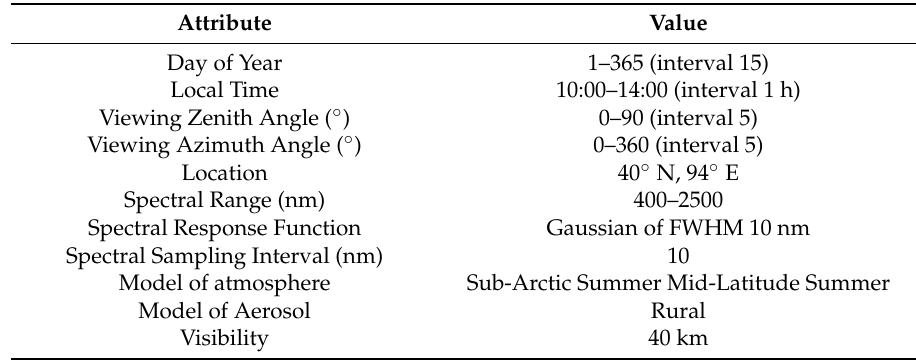
Table 1. Parameters Used in MODTRAN Simulation.